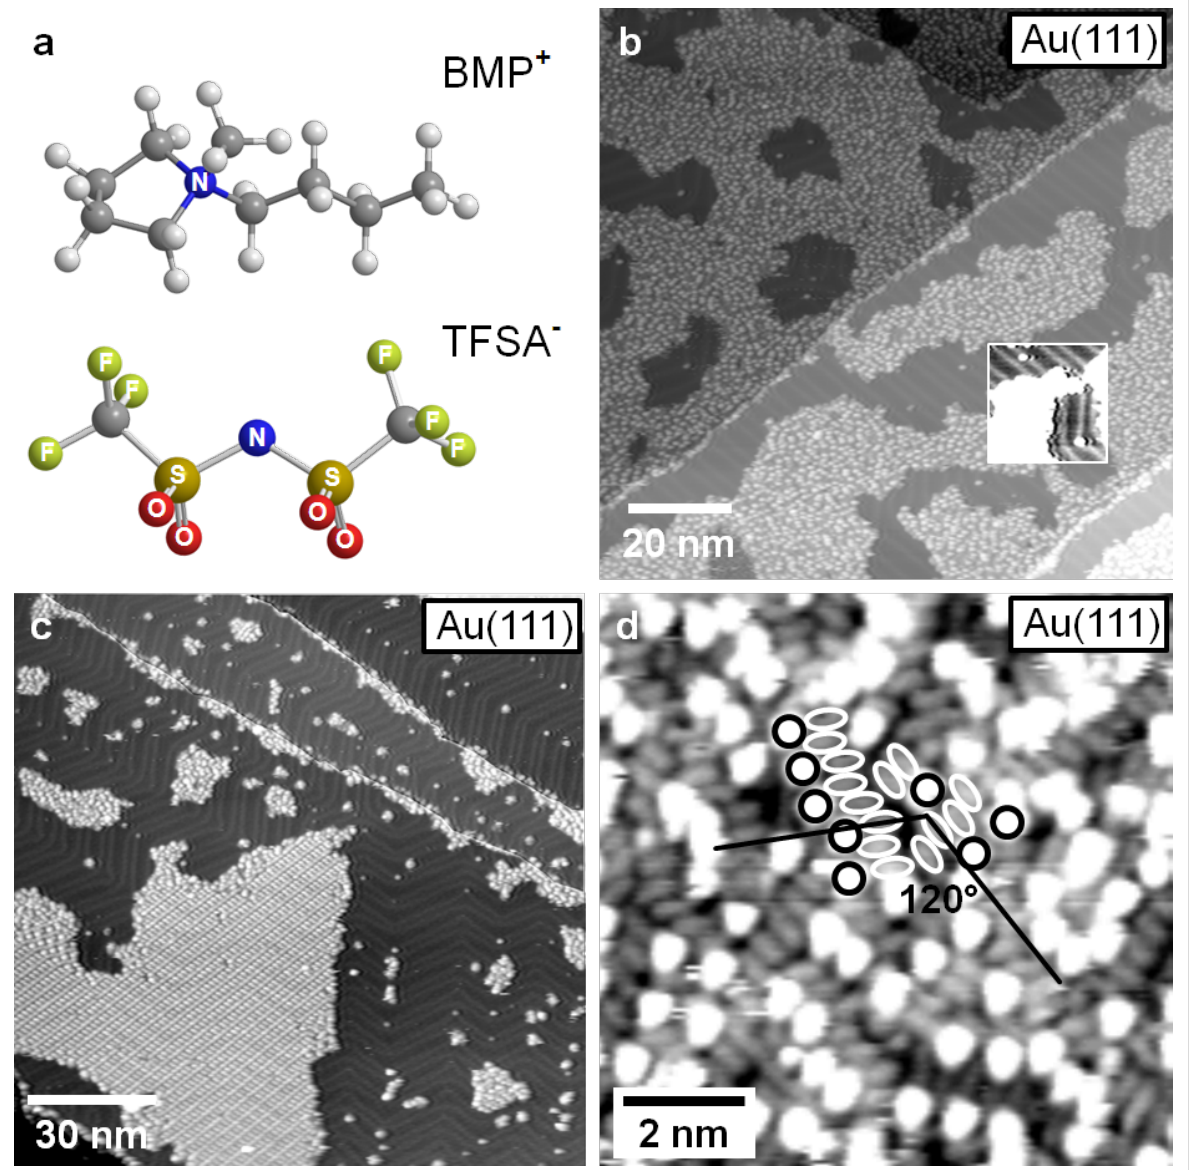
Figure 1: (a) Ball and stick model of 1-butyl-1-methylpyrrolidinium-bis(trifluoromethylsulfonyl)imide [BMP][TFSA] (grey: C, white: H, blue: N, red: O, green: S, yellow: F) (drawn with Chem3D). (b) STM image of a Au(111) surface covered with 0.7 ML of [BMP][TFSA] arranged in islands of the 2D glass phase. Inset: detail of the image in (b) with enhanced contrast between the adsorbate islands, resolving the Au(111) reconstruction pattern ( T = 112 K, U T = − 1.9 V, I T = − 40 pA); (c) STM image of a Au(111) surface with a small amount ( ≈ 0.2 ML) of adsorbed [BMP][TFSA], resolving the preferential decoration of steps and the nucleation of small islands with 2D glass structure at the elbows of the Au(111) reconstruction, while islands with a 2D crystalline structure have grown larger. The Au(111) reconstruction pattern is visible on the uncovered parts of the surface ( T = 111 K, U T = − 1.74 V, I T = − 0.020 nA). (d) High resolution image of the 2D glass phase on Au(111): longish protrusions with a lower height are visible between the round shaped protrusions (partly marked by white circles and ellipsoids) ( T = 119 K, U T = − 1.06 V, I T = 80